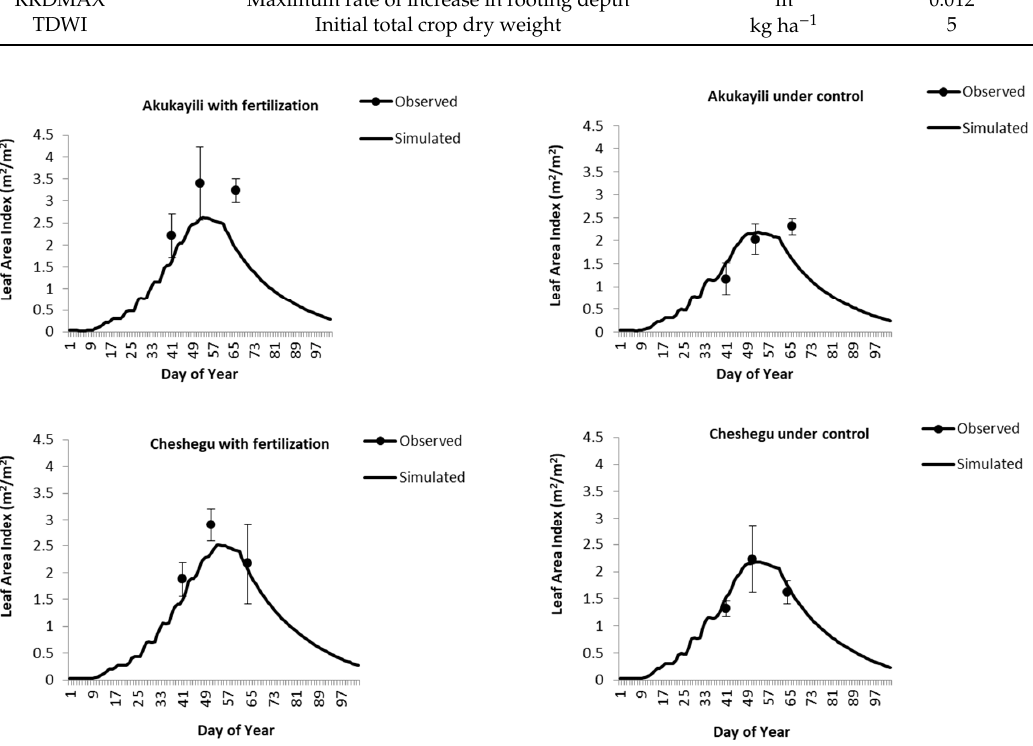
Figure 1. Observed and simulated Leaf Area Index (m 2 / m 2 ) at two experimental sites Akukayili (upper row) and Cheshegu (lower row) in Ghana under fertilized and control conditions.